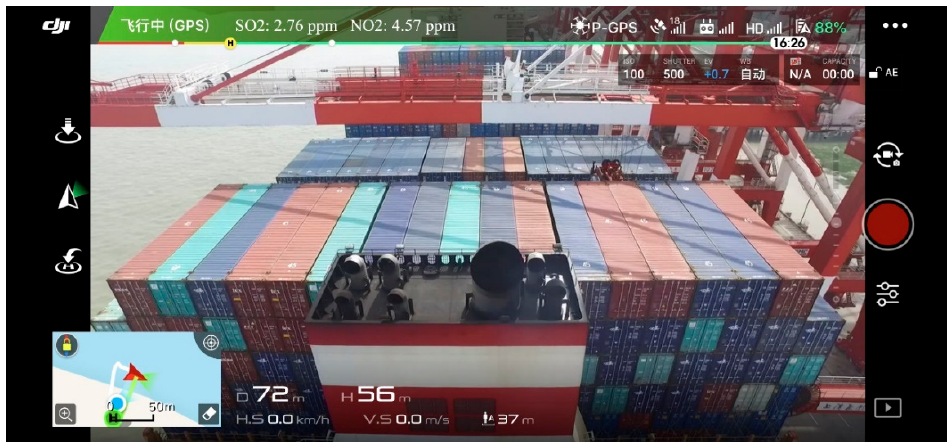
Figure 4. Illustration of a mobile control terminal phone display interface.